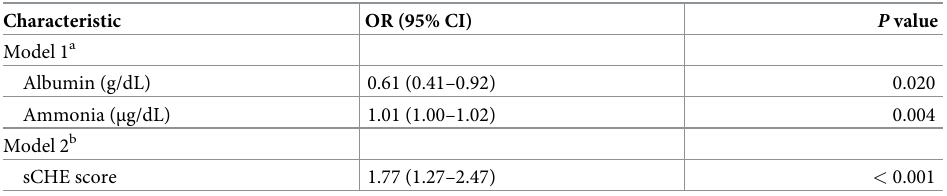
Adjusted for age, sex, etiology of cirrhosis, and sCHE score. Abbreviations: CHE, covert hepatic encephalopathy; CI, confidence interval; OR, odds ratio; sCHE, simple covert hepatic encephalopathy.